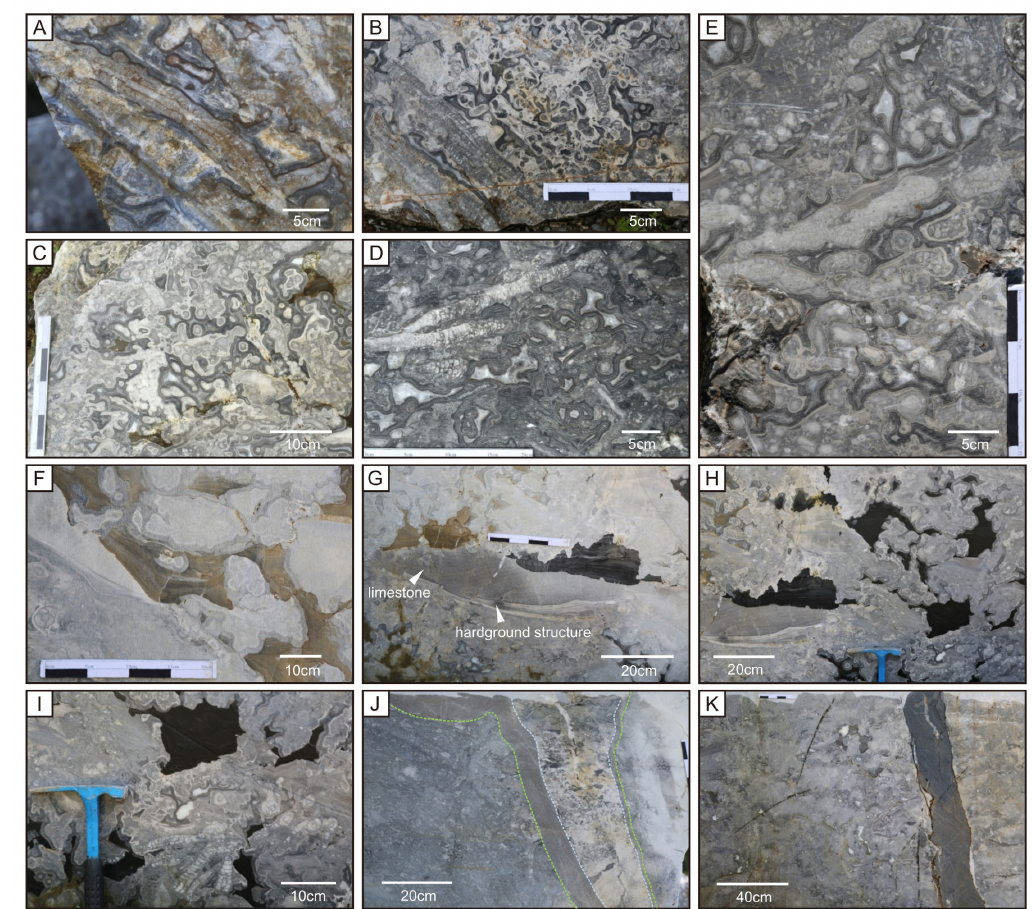
Figure 7. Images of the outcropping lithofacies: ( A ) open-skeleton sponge framestone; ( B ) open-skeleton sponge framestone showing upright and toppled position of sphinctozoan